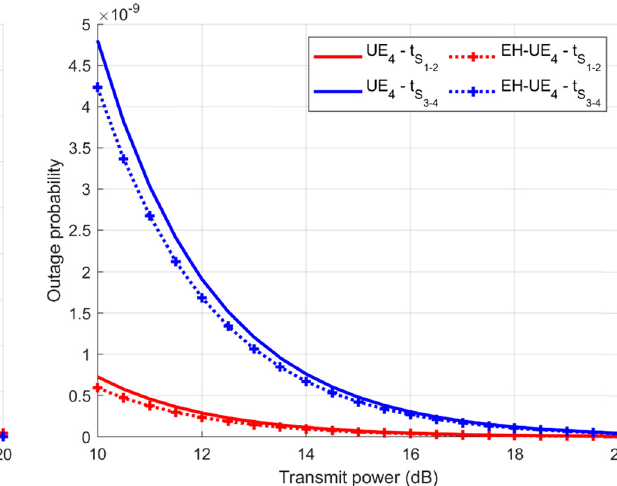
Figure 6: Outage probability of user